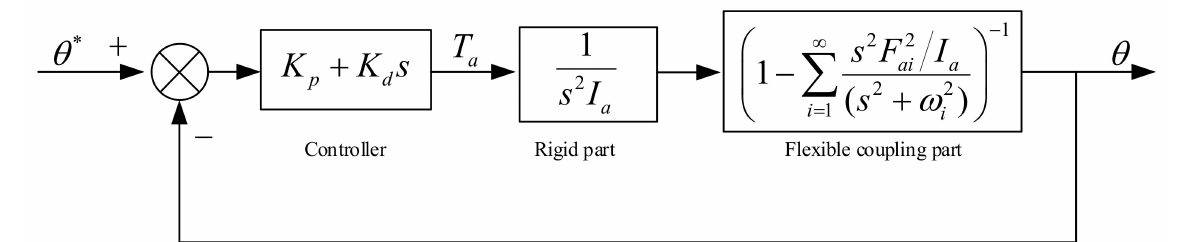
Figure 5. Schematic diagram of position loop for flexible